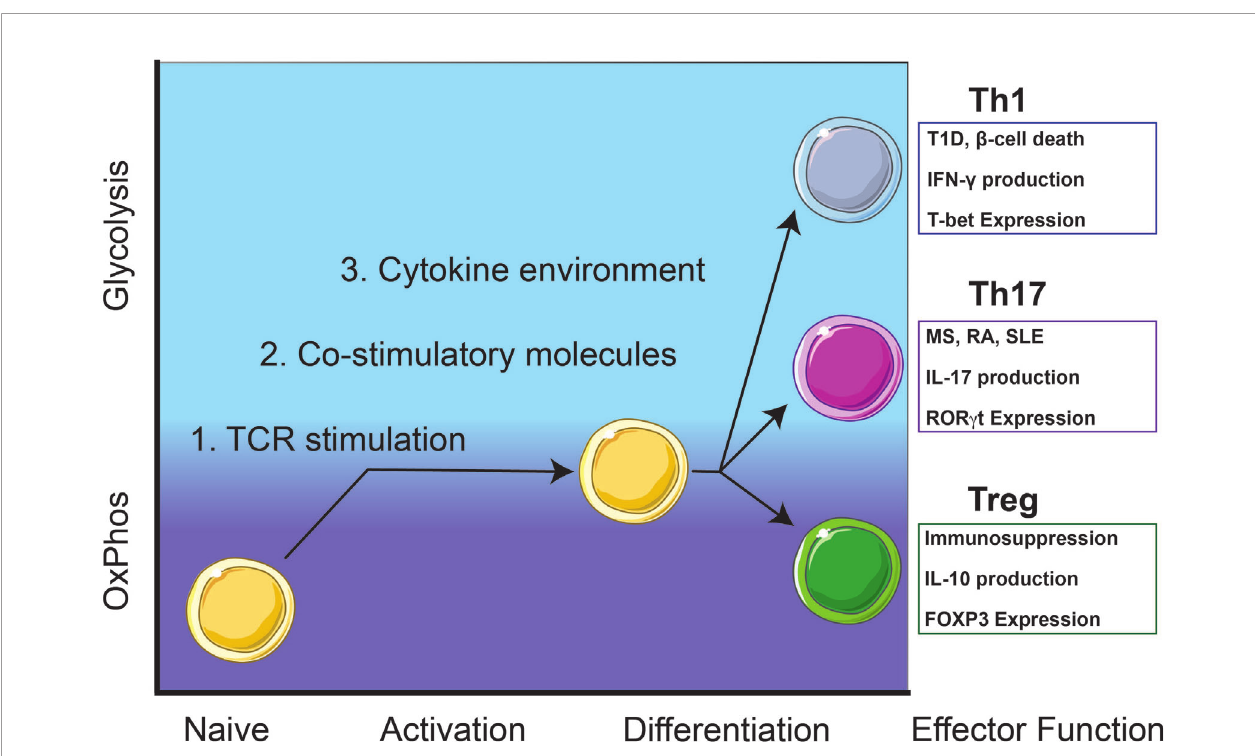
FIGURE 1 | Autoreactive Th1 and Th17 T cell responses rely on glycolysis while immunosuppressive Treg cells utilize oxidative phosphorylation (OxPhos). Th1 cells contribute to b -cell death and destruction in type 1 diabetes (T1D) and Th17 cells contribute to pathogenesis of other T-cell mediated diseases including multiple sclerosis (MS), rheumatoid arthritis (RA), and systemic lupus erythematosus (SLE). Upon activation, naïve T cells will metabolically shift from OxPhos-dependence to a balance between glycolysis and OxPhos. Throughout early activation and differentiation, this balance is maintained until a commitment toward an effector function is achieved. Once fully differentiated, autoreactive Th1 and Th17 cells utilize glycolysis for homeostasis and maintenance while immunosuppressive Treg cells rely on